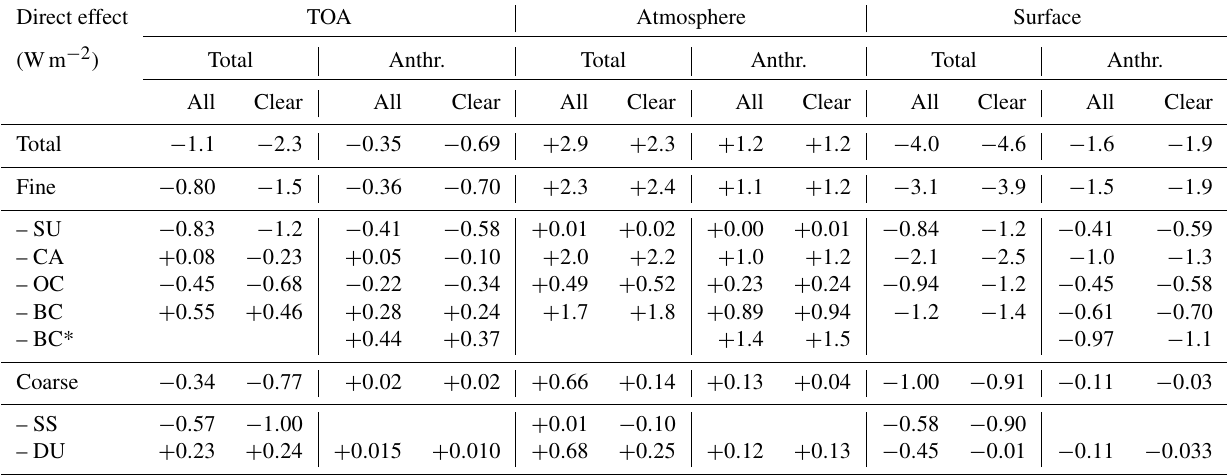
Table 2. Annual average MACv2 climatology associated aerosol radiative effects for today’s tropospheric aerosol at the top of the atmosphere (TOA), at the surface and (by difference) for the atmosphere. Aside from total aerosol (in row 1), effects of components and if applicable their anthropogenic (Anthr.) contributions are also indicated. Considered fine-mode components are sulfate (SU), organic matter (OC), soot (BC) and the combined carbon (OC + BC). Considered coarse-mode components are sea salt (SS) and dust (DU).